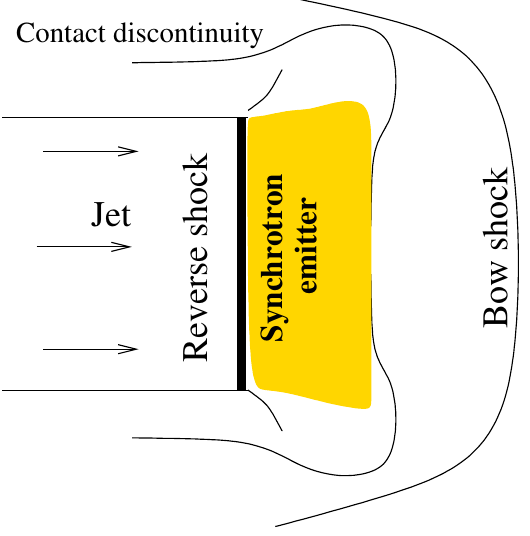
Figure 2. Sketch of the jet termination region. Particles are ac- celerated at the reverse shock, and radiate in the shock down- stream region (the